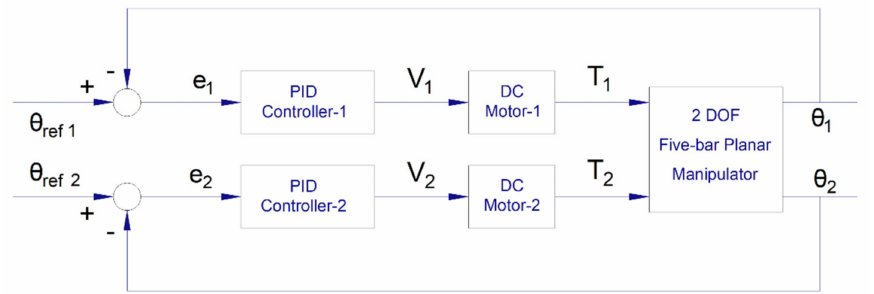
Figure 8. Block diagram of PID controlled